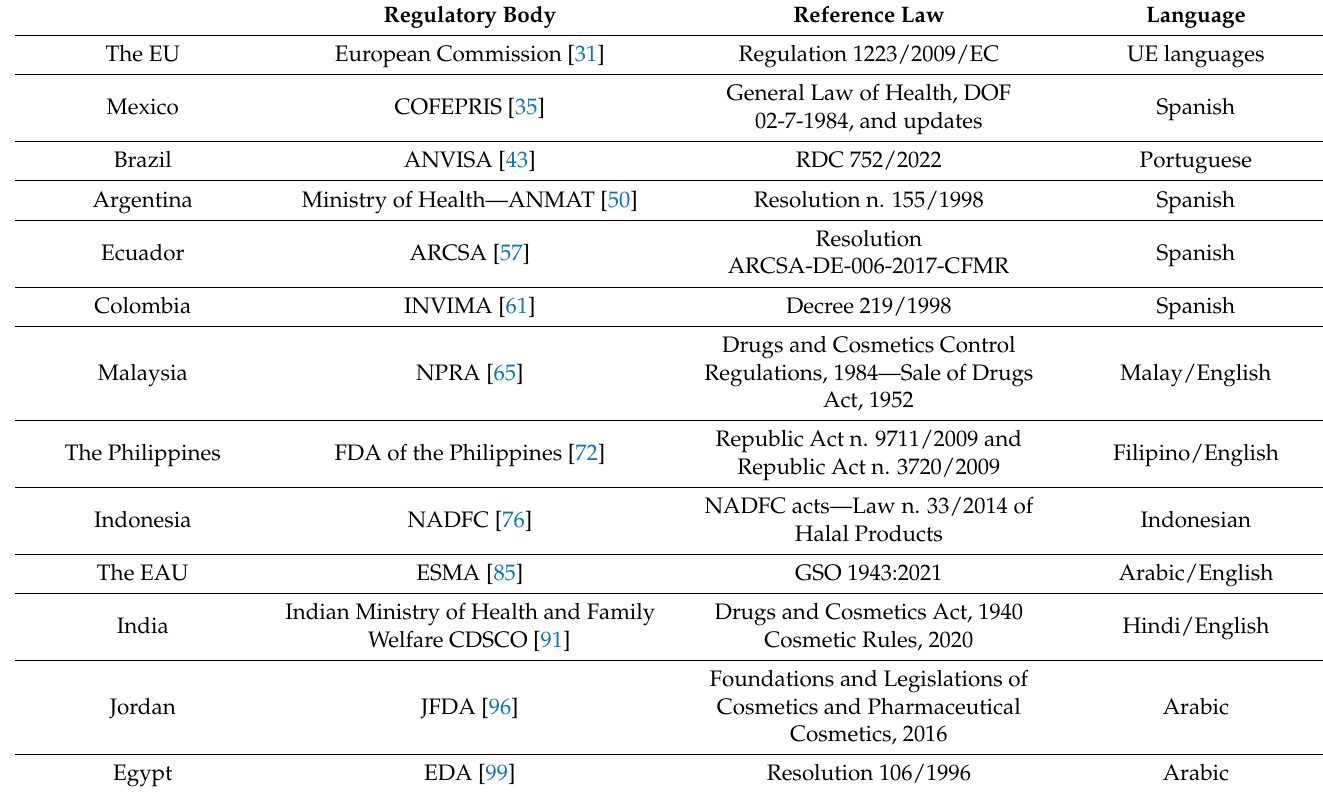
Table 2. List of regulatory bodies, reference laws, and